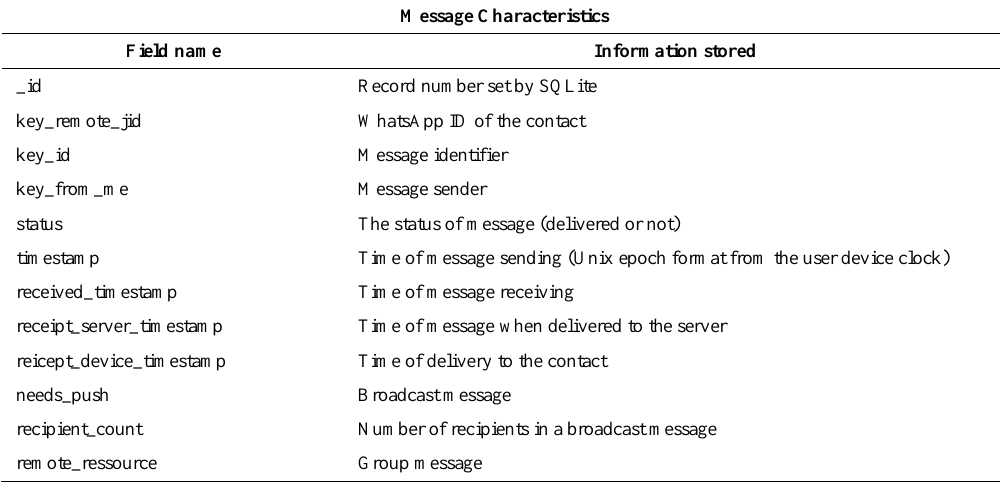
Table 8. Structure of the chat database msgstore.db - message characteristics